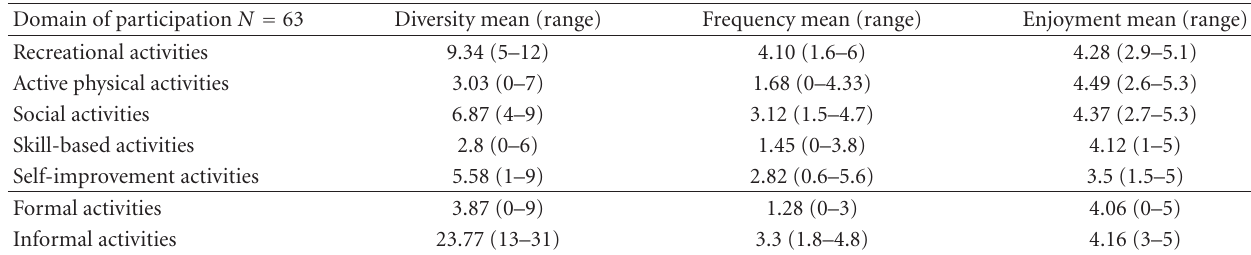
Table 3: Mean scores of domains of participation in leisure activities as assessed by the